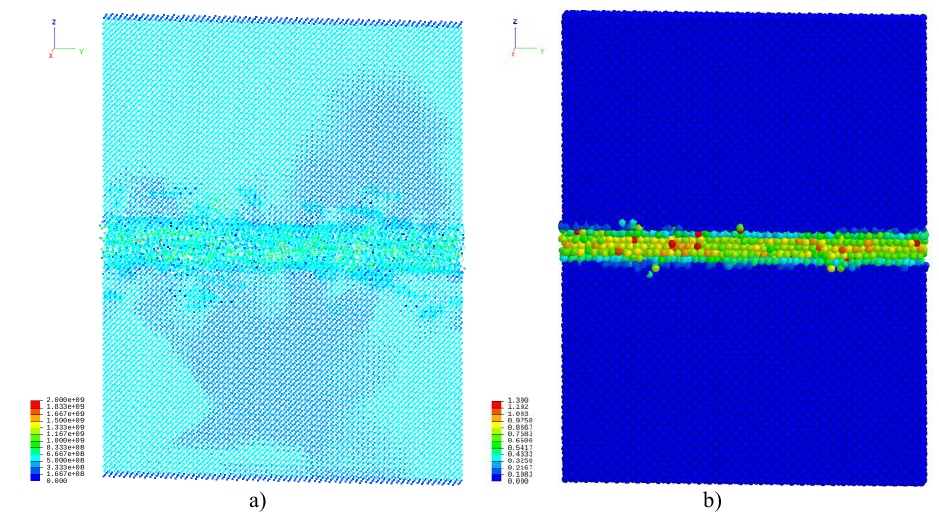
Fig. 4. Fields of equivalent stress (a, points are centres of automata) and strain (b, automata shown as spheres) in the cross-section of the composite specimen at the final stage of the simulation.